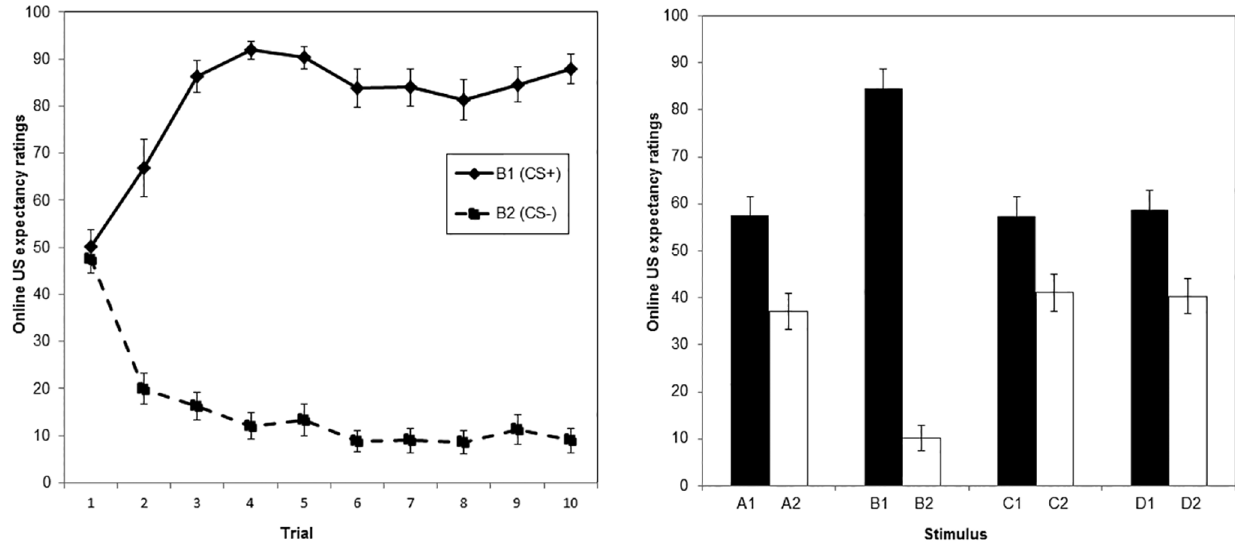
Figure 3. Mean expectancy ratings over de acquisition phase and generalization of acquisition test. Ratings were registered at the moment the stimulus and expectancy scale disappeared from the screen. Higher levels indicate more certainty about shock (100= ‘‘Certainly a shock’’), lower levels indicate more certainty about absence of shock (0= ‘‘Certainly no shock’’). The left panel represents the data from the acquisition phase, per trial, for both the CS + (B1) and the CS- (B2). The right panel shows the data from the generalization of acquisition test of all stimuli from both categories. Each stimulus was presented once during this phase.